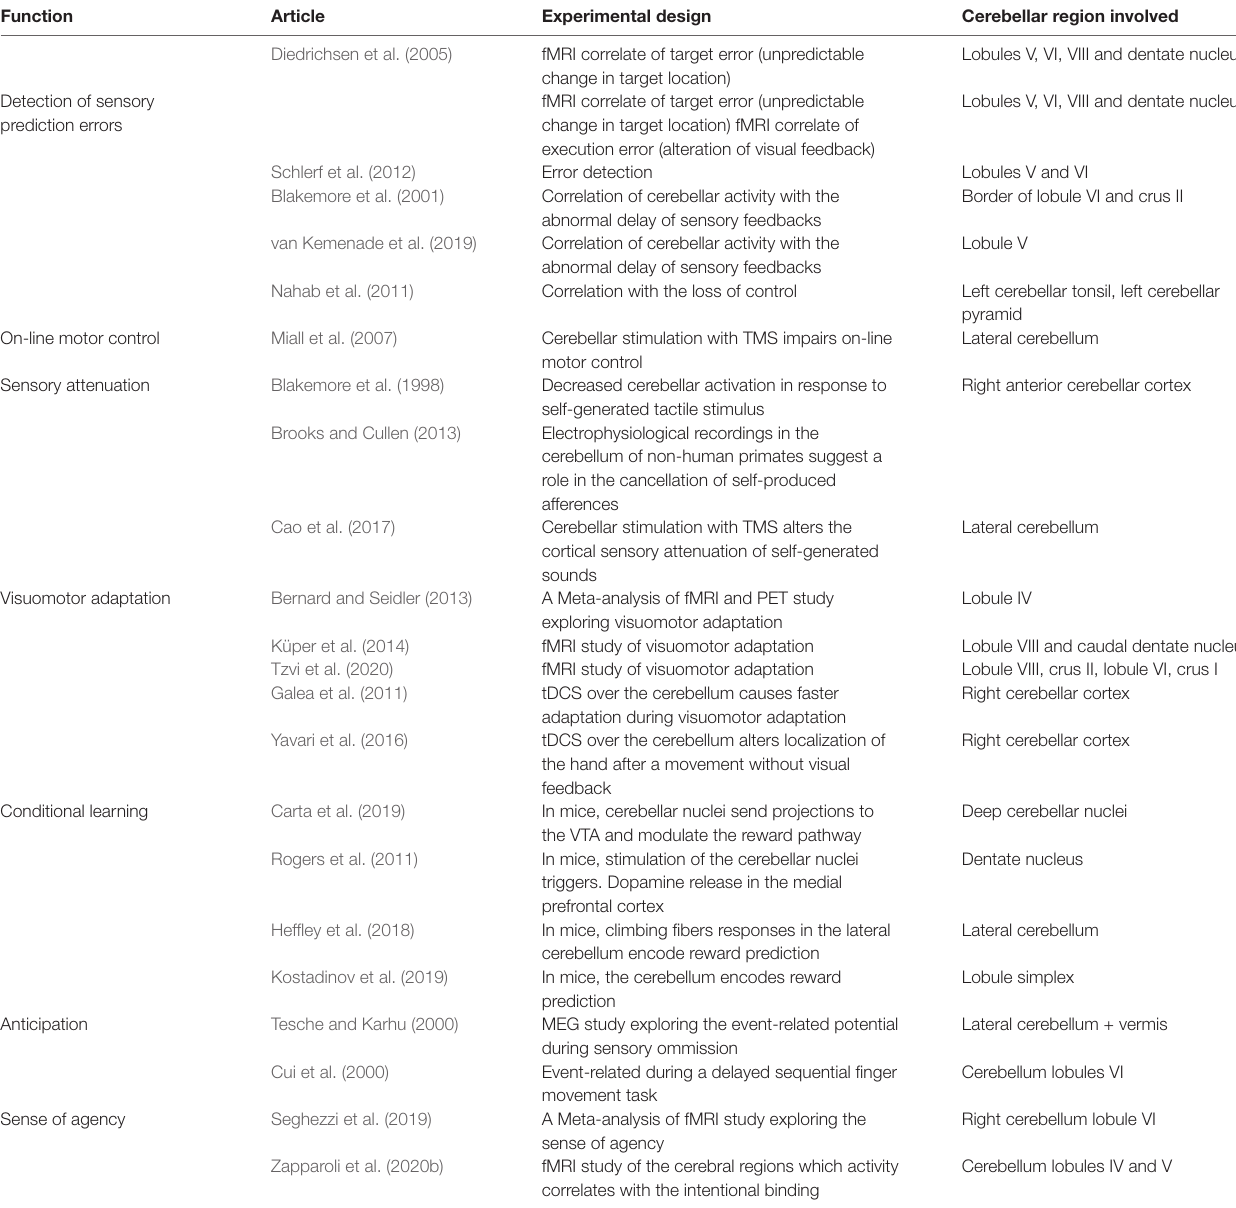
TABLE 1 | Cerebellar functional anatomy related to functions associated with the forward model and the sense of agency.